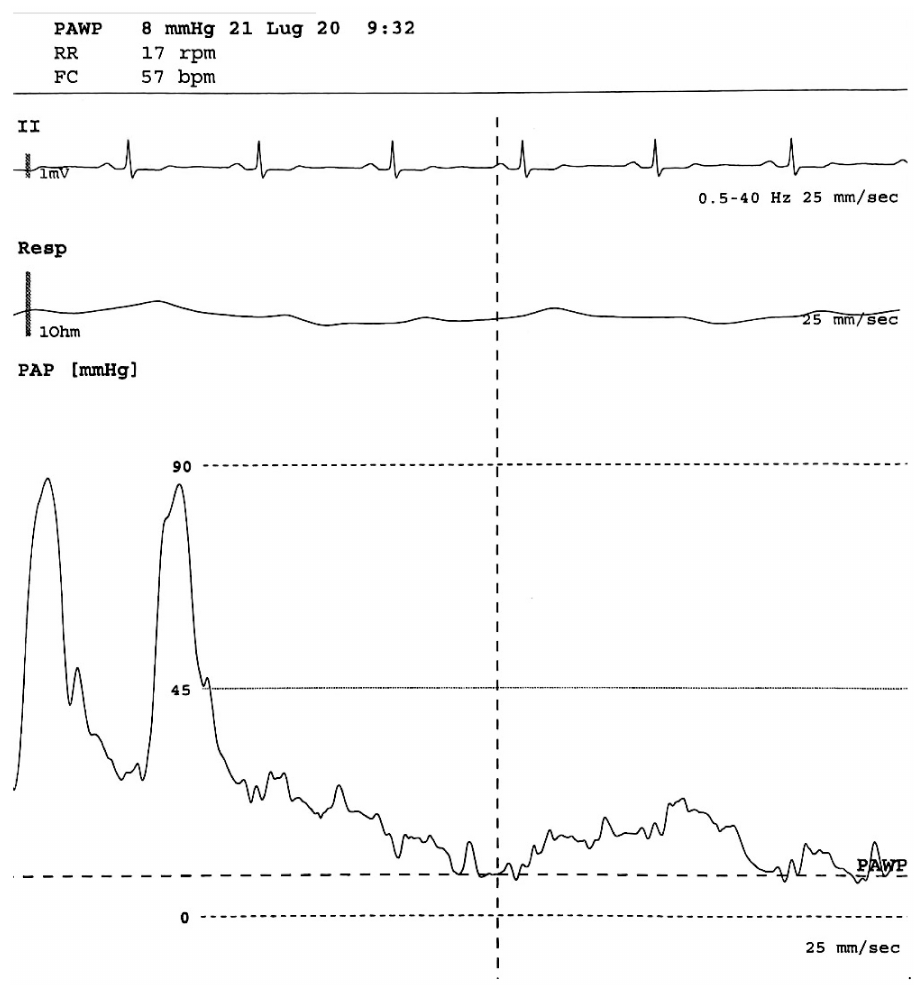
Figure 2. From below: pulmonary arterial pressure, respiratory and EKG waveforms during arterial catheterization. The first part of the pressure trace reflects the pressure in a pulmonary artery (large swings, dicrotic notch), then the balloon is inflated and the tip of the Swan Ganz catheter floats until it wedges in a small artery (small swings synchronous with respiratory rate), allowing a pulmonary arterial wedge pressure (PAWP) to be obtained, which is an indirect measure of left ventricle